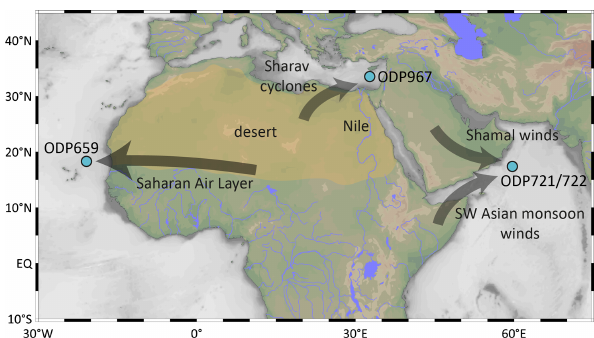
Figure 1. Location of ODP Site 967 in the eastern Mediterranean Sea, ODP Site 659 in the eastern Atlantic Ocean, and ODP Sites 721 and 722 in the Arabian Sea. The transparent black arrows indi- cate the main winds that transport dust to these sites (after Trauth et al.,